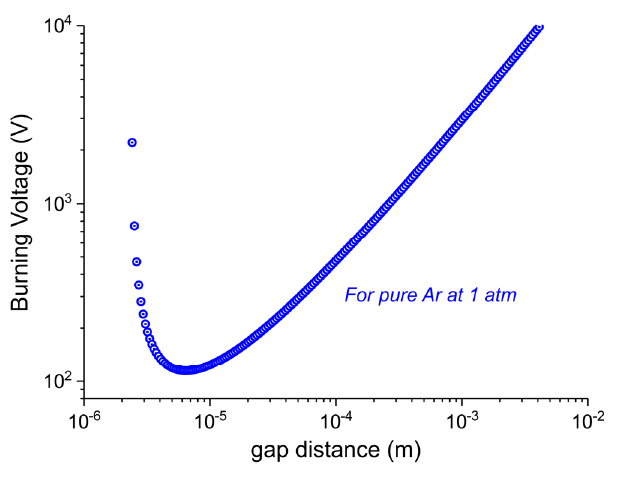
Figure A13. Burning voltage in function of the gap distance for argon at 1 atm, as calculated by [59].